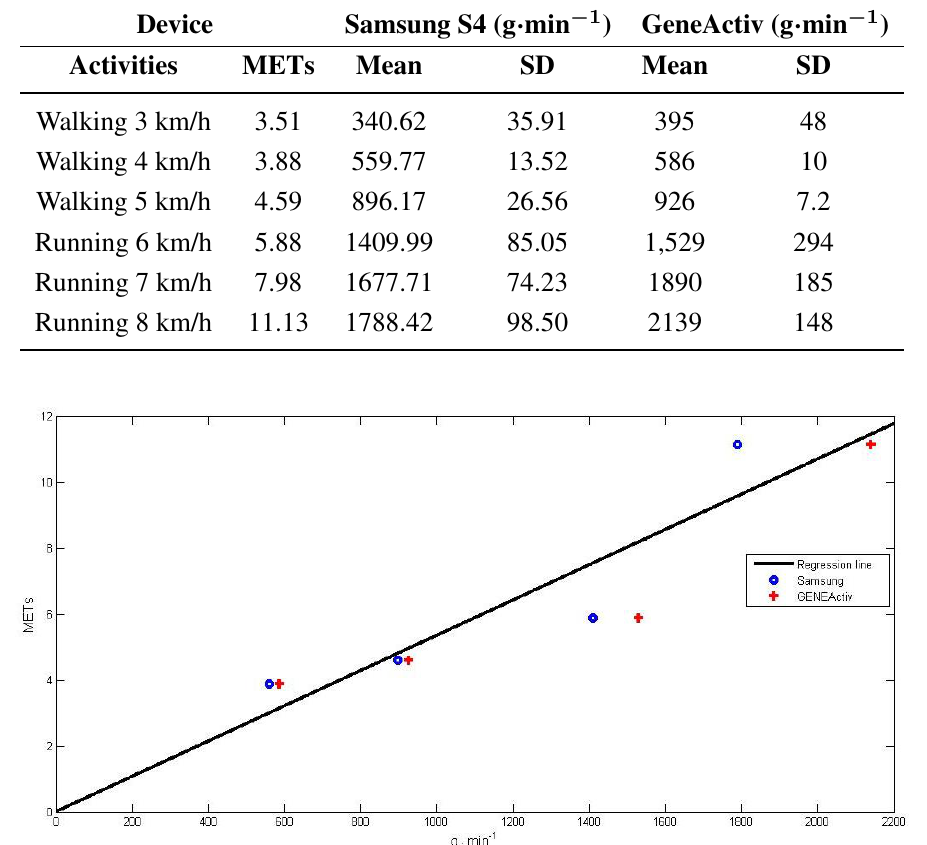
Figure 4. Relationship between GeneActiv and Samsung